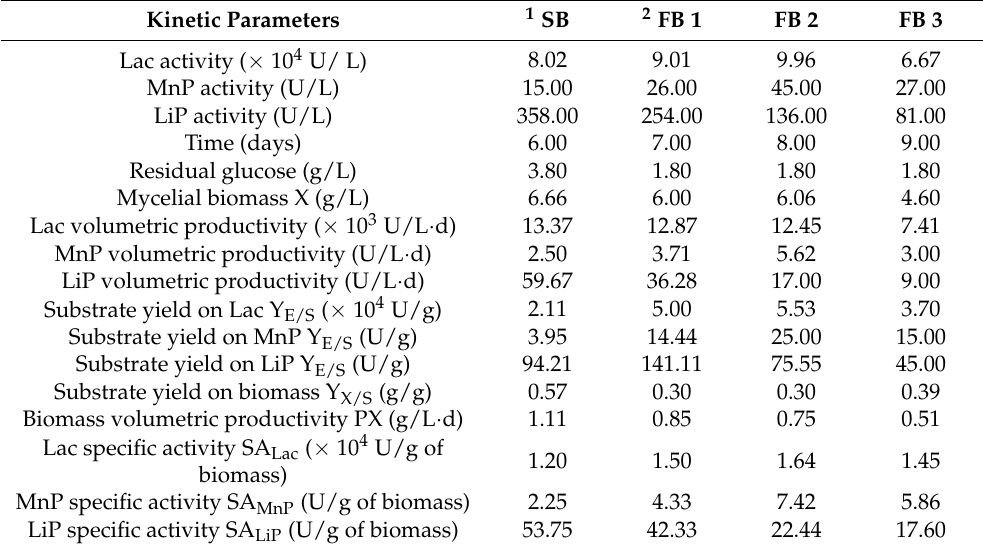
Table 4. Kinetic parameters by enzymatic production of P. sanguineus 2512 in 2L-BCR yield factors, productivity and specific